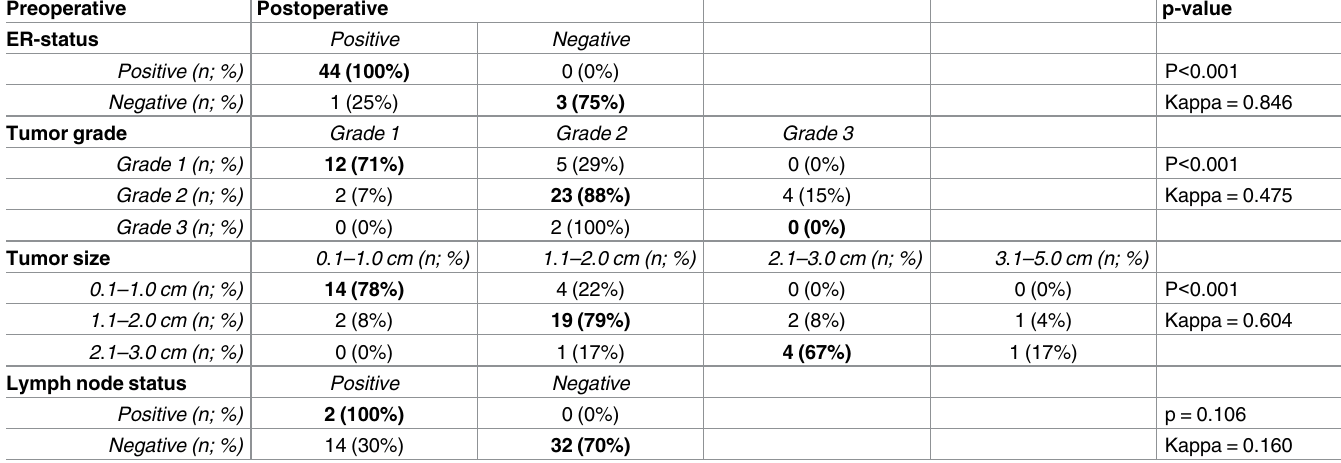
Table 1. Association between the preoperative and postoperative tumor characteristics on conventional diagnostic workup. ER = Estrogen receptor.